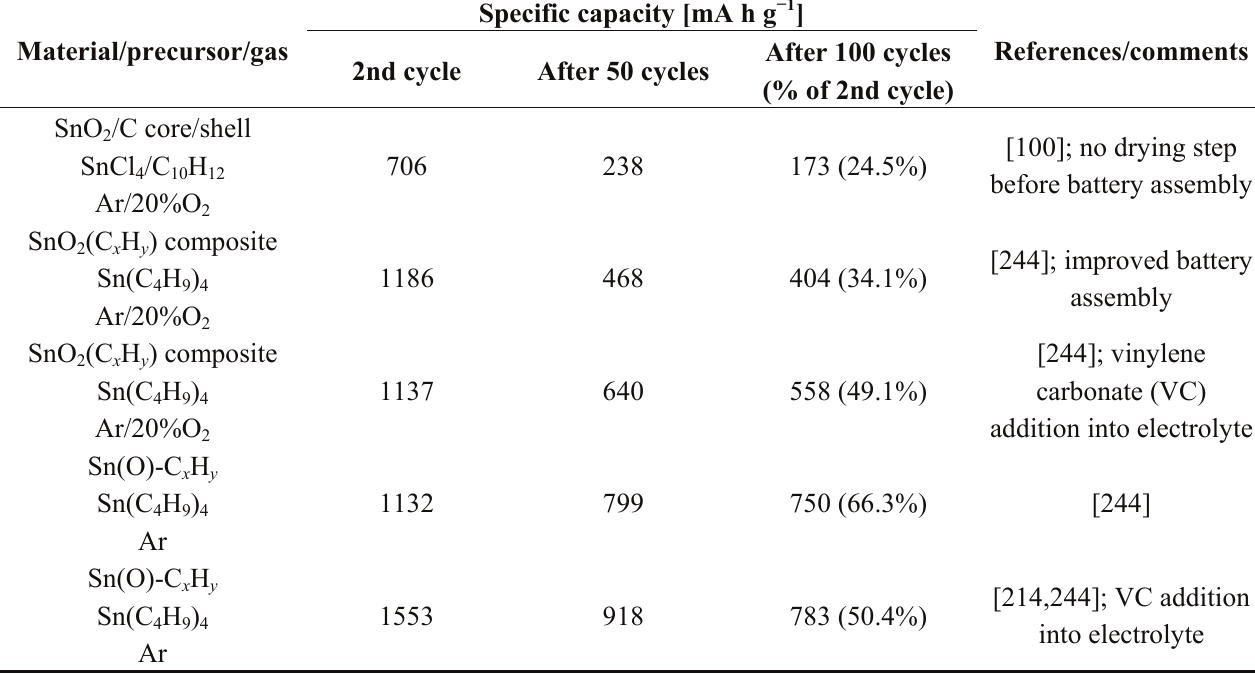
Table 9. Evolution of Li-ion battery performance through targeted synthesis of nanocomposites using microwave plasma